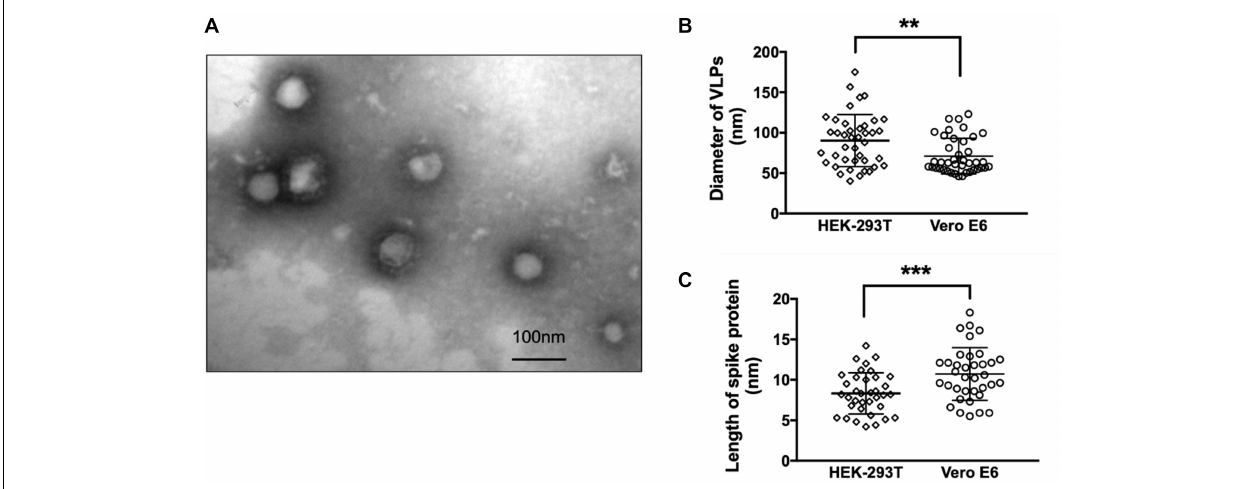
FIGURE 3 | Morphological evaluation of SARS-CoV-2 VLPs. (A) TEM images of SARS-CoV-2 VLPs constructed from Vero E6 cells 48 h after co-transfection of S, M, E, and N plasmids with molar ratio at 8:6:8:3. Scale bar = 100 nm. (B) Quantification and comparison of diameters of SARS-CoV-2 VLP particles formed from both HEK-293T and Vero E6 cells. (C) Quantification and comparison of the length of spike proteins incorporated into SARS-CoV-2 VLP particles derived from both HEK-293T and Vero E6 cells. ** p < 0.01; *** p < 0.005. Data were mean ±